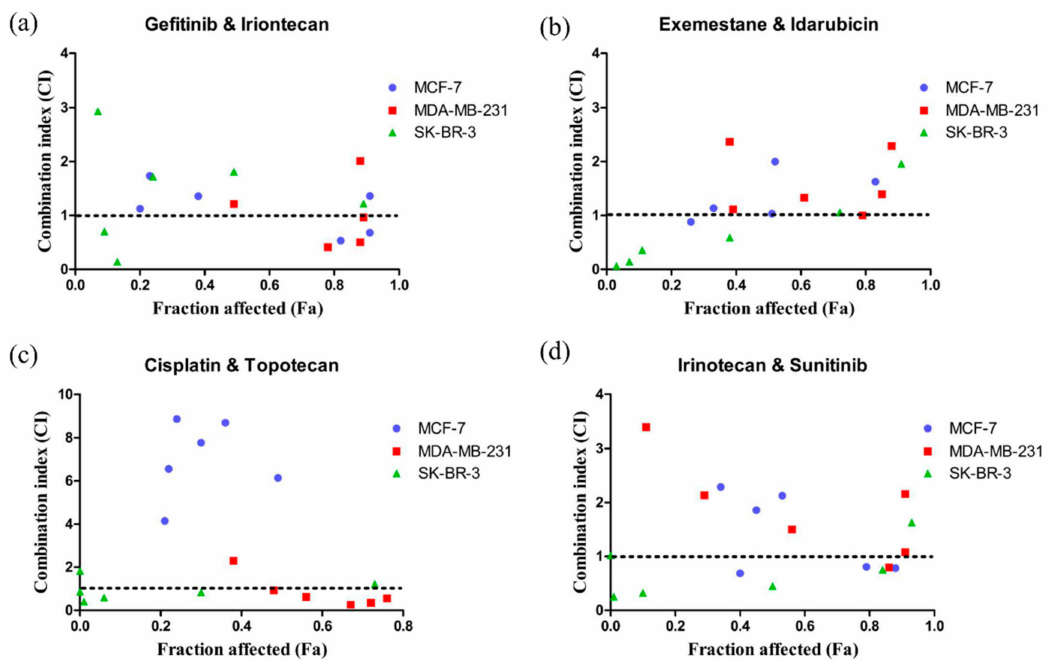
Figure 4. Scatter plots of CI versus Fa. ( a ) gefitinib combined with irinotecan. ( b ) exemestane combined with idarubicin. ( c ) cisplatin combined with topotecan. ( d ) irinotecan combined with sunitinib. The synergistic effect of the combination of gefitinib and irinotecan on MCF-7, MDA-MB-231, and SK-BR-3 cells can be seen. The CI value and fraction affected (Fa) was calculated via CompuSyn software (ComboSyn, Inc., Paramus, NJ. 07652 USA). CI < 1 indicates a synergistic effect, CI = 1 indicates an additive effect, and CI > 1 indicates an antagonistic effect. Fa value represents the effect of the drug, that is, the tumour cell inhibition